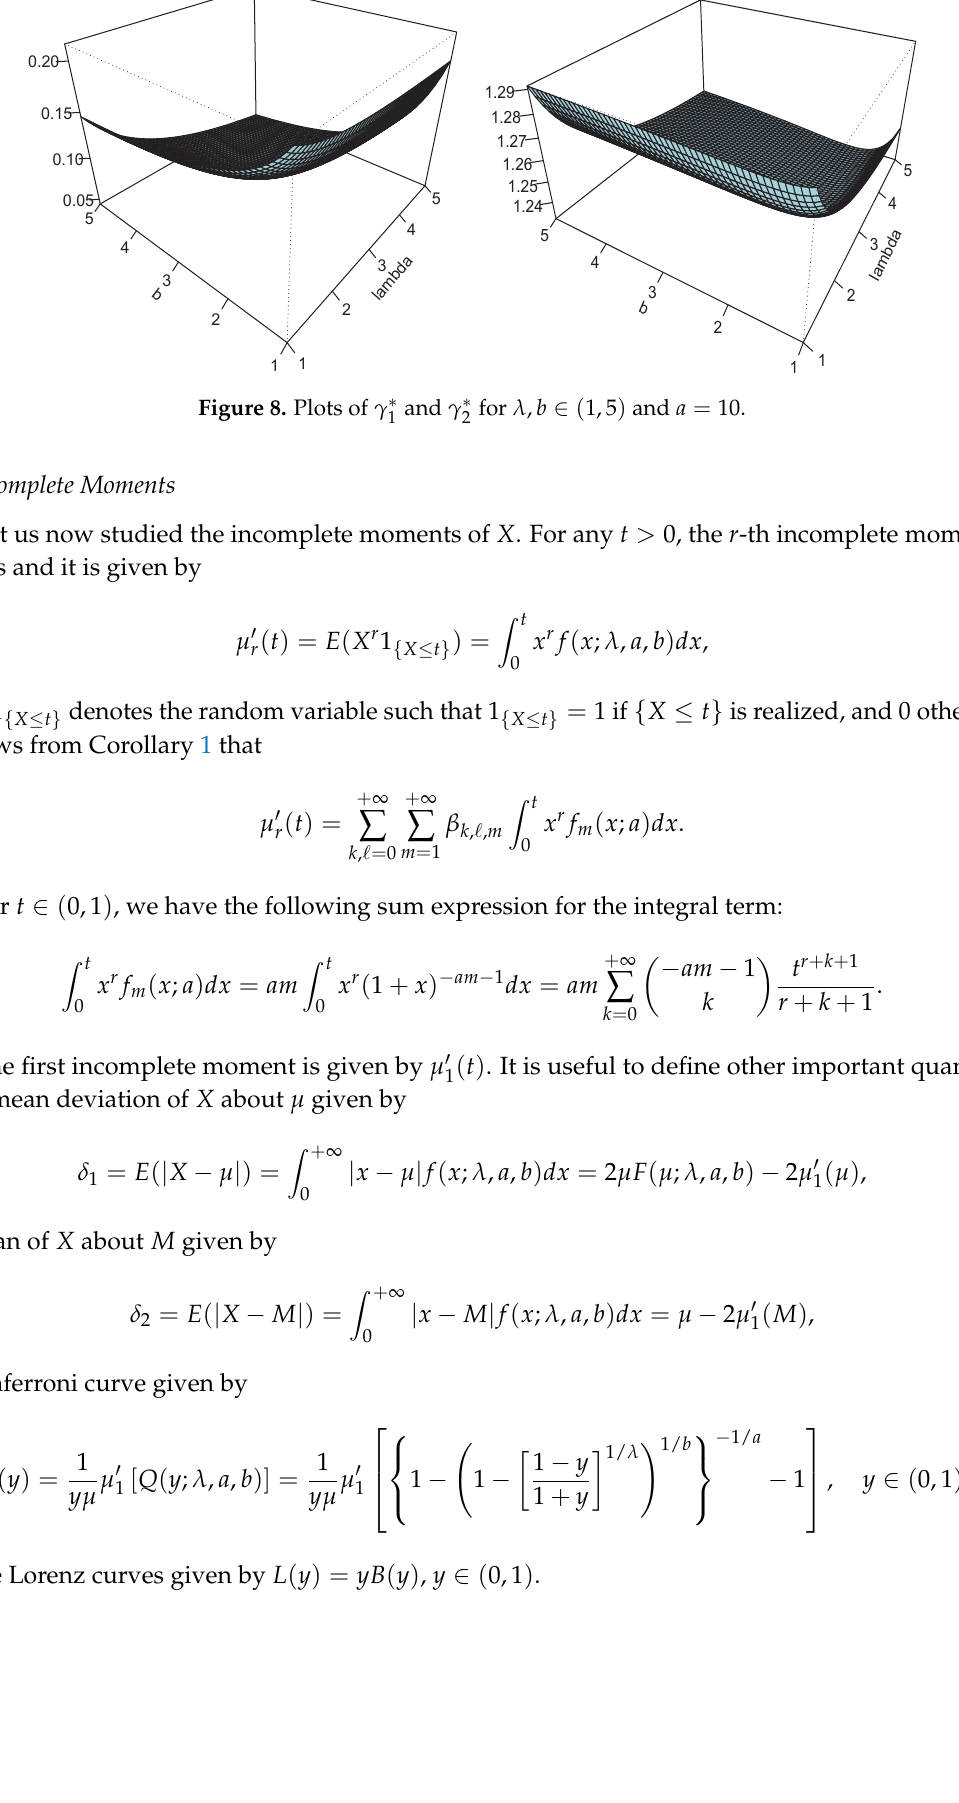
Figure 8. Plots of γ ∗